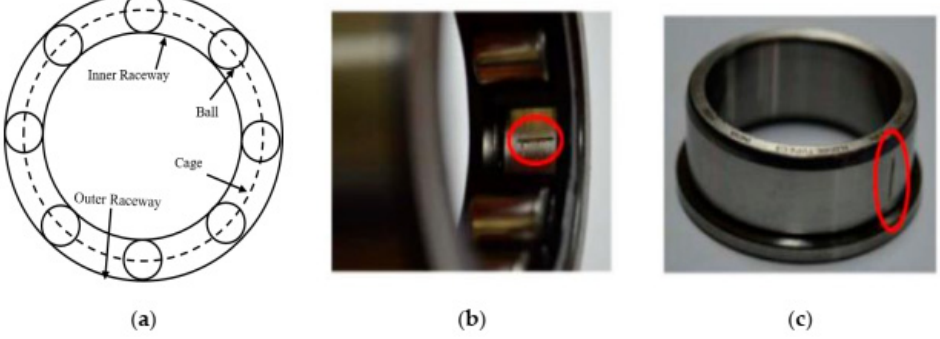
Figure 3. ( a ) Geometric structure of bearing; ( b ) fault in outer raceway; ( c ) fault in the inner race- way.